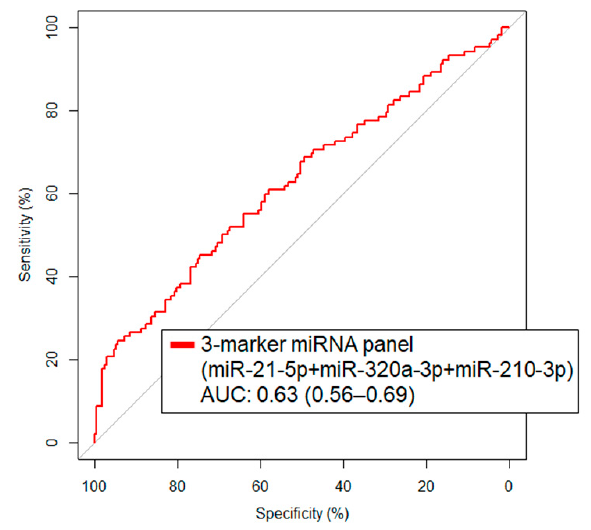
miRNA panel plus 4MP resulted in statistically significantly improved sensitivity (19.1%